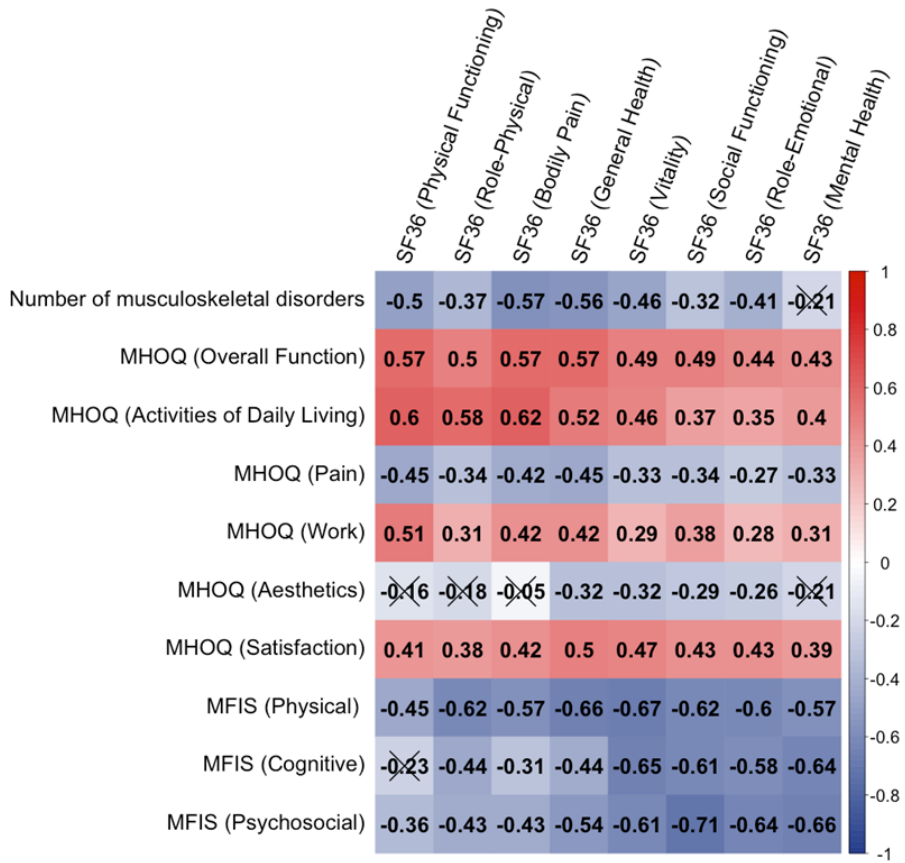
Figure 1. Correlogram representing the Spearman correlation coefficient regarding the number of musculoskeletal disorders, various dimensions related to the hand function (MHQ) and fatigue (MFIS), and the 8 quality of life dimensions of the SF-36 scale. The colour and brightness of each square represent the magnitude and sign of each correlation (red = positive, blue = negative), respectively. The X indicates a nonsignificant correlation ( p > 0.05; with Bonferroni–Holm